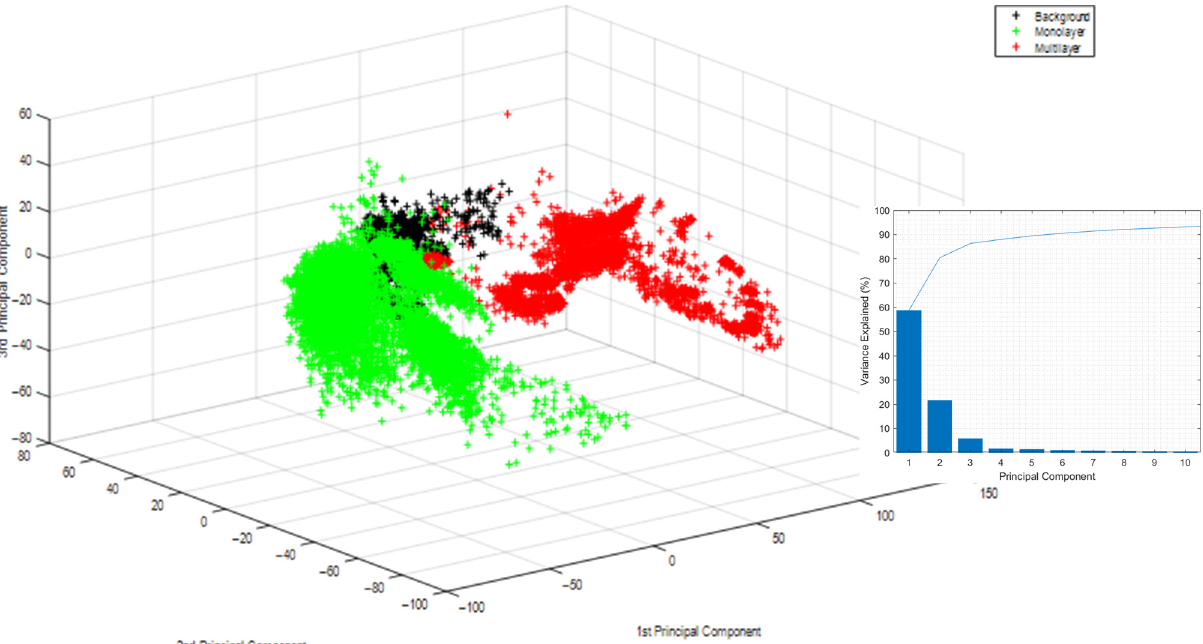
Figure 20. Result of the principal component analysis of approximately 17,000 spectra of monolayer, multilayer and background material to discern their sortability.